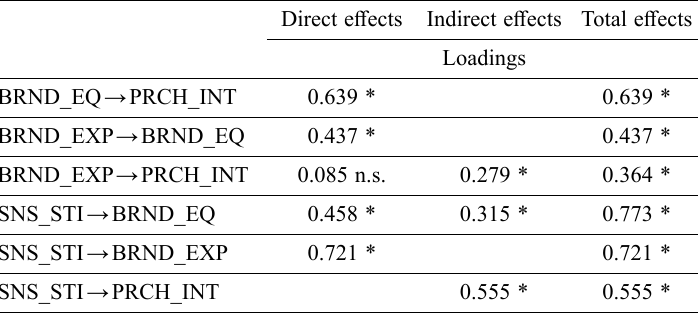
Table 4. Direct, indirect and total